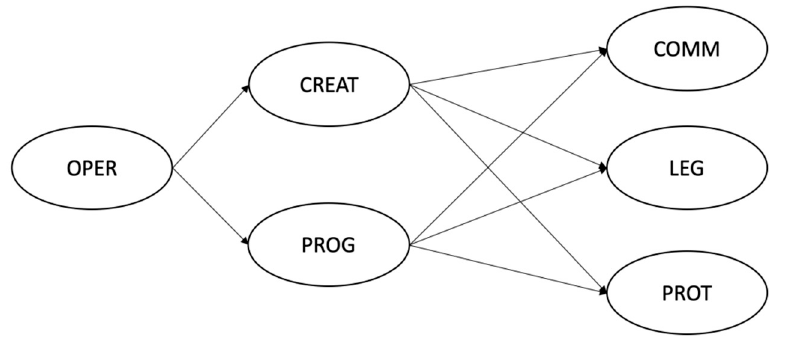
Figure 2. Theoretical model of connections between digital competence dimensions (OPER—performing operations with digital tools, CREAT—creating digital materials, PROG—programming digital content, COMM—communicating in the digital world, LEG—legal behaviour in the digital world, PROT—protecting oneself and others in the digital world).